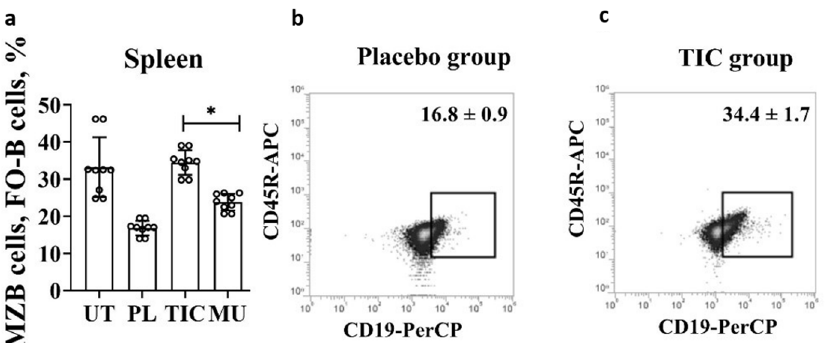
Figure 3. Results of flow cytometric phenotypic analysis of MZB cells and FO-B cells. ( a ) The average volume of MZB cells and FO-B cells (B220/CD45R + (APC)CD19 mid (PerCP)CD43 − (PE)) in the spleen.